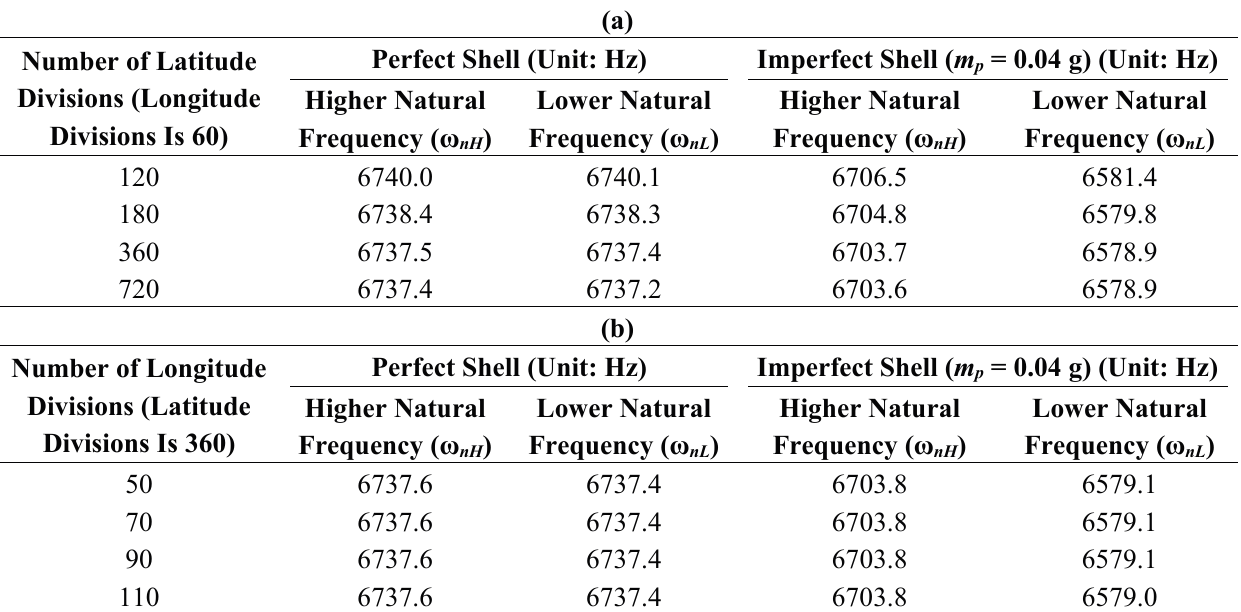
Table 2. ( a ) The impacts of latitude divisions on simulation results; ( b ) The impacts of longitude divisions on simulation